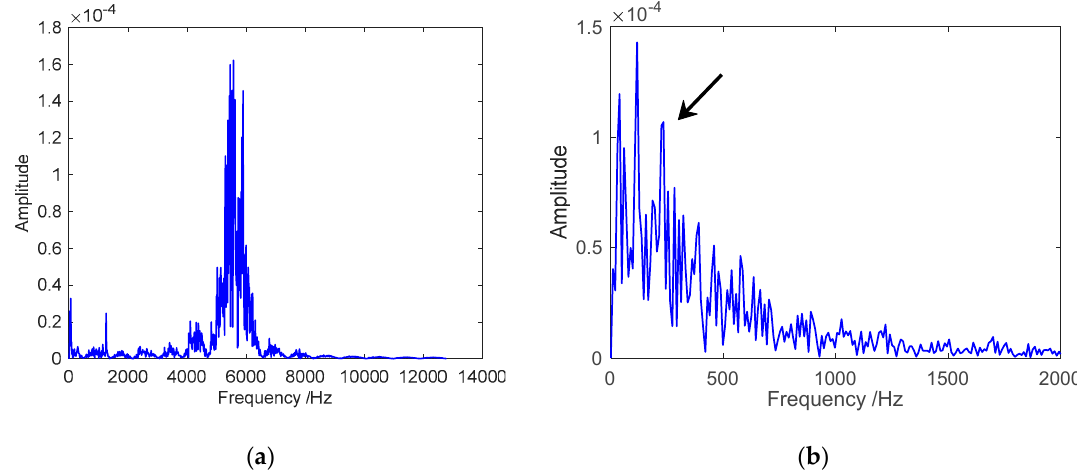
Figure 10. Results based on singular value decomposition (SVD): ( a ) SVD-reconstructed spectrum; and ( b ) the corresponding envelope spectrum.